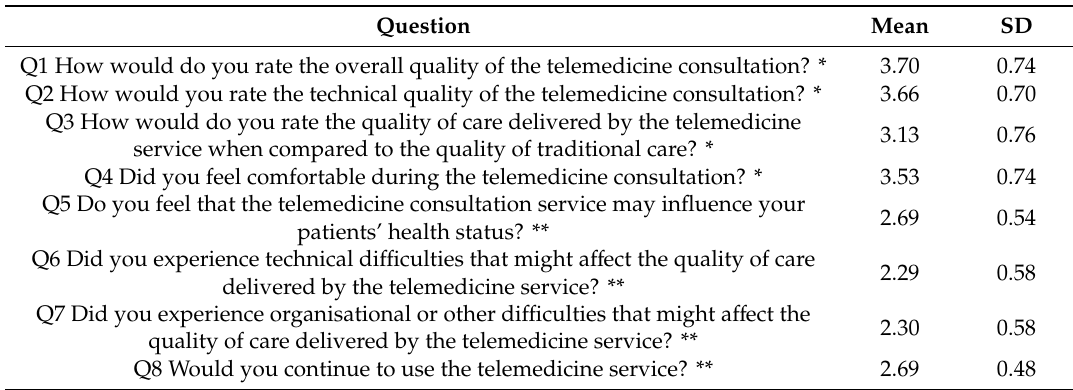
Table 2. Main Survey